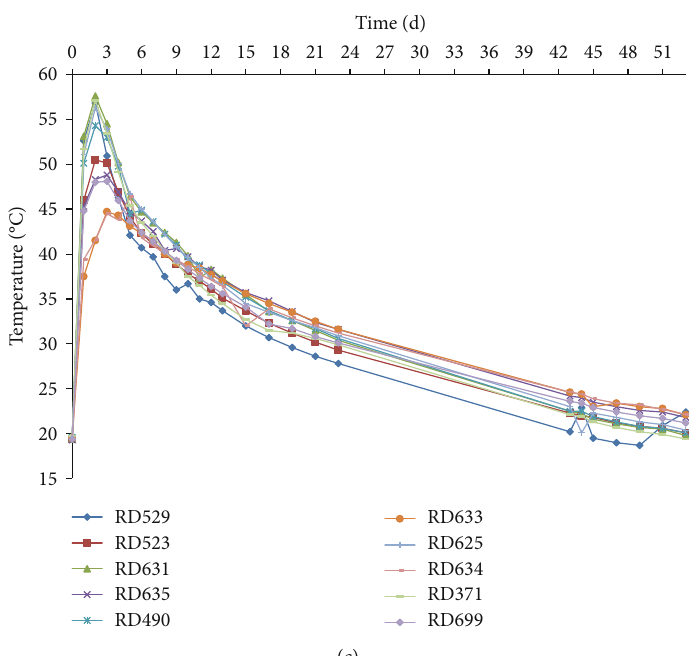
Figure 3: Field data: (a) stress-time curve for the upper layer of rebar, (b) stress-time curve for the lower layer of rebar, and (c) temperature- time curve.